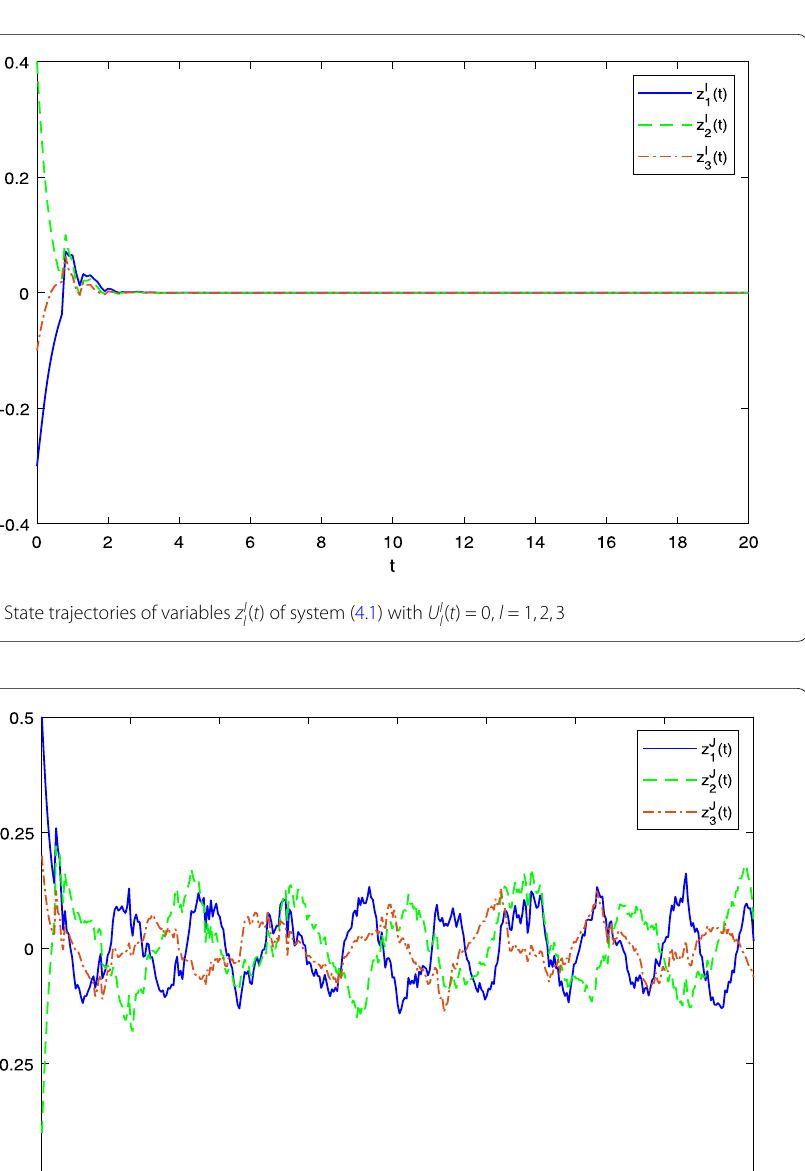
( t ) of system (4.1) with U J l